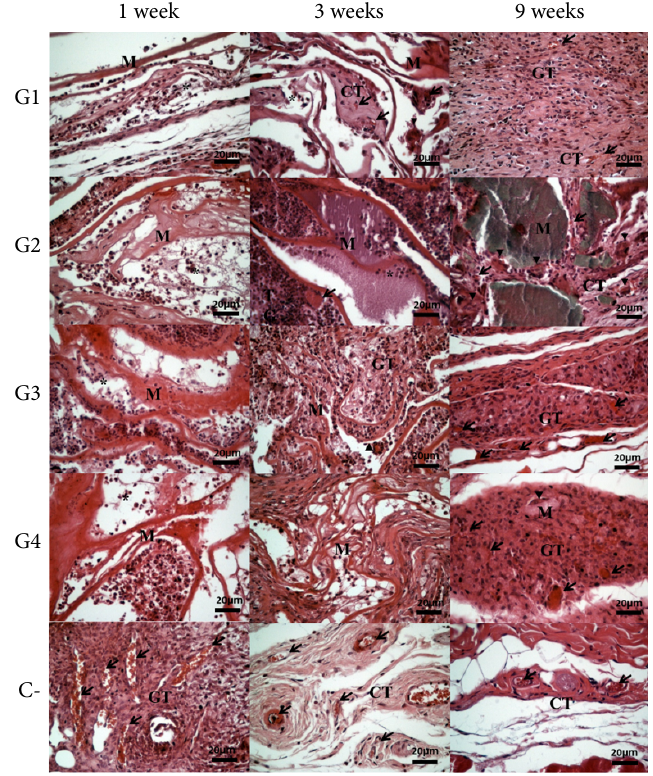
Figure 3 - Biocompatibility analysis of poultry collagen-based hydrogels in subcutaneous tissue in mice at one, three and nine weeks.